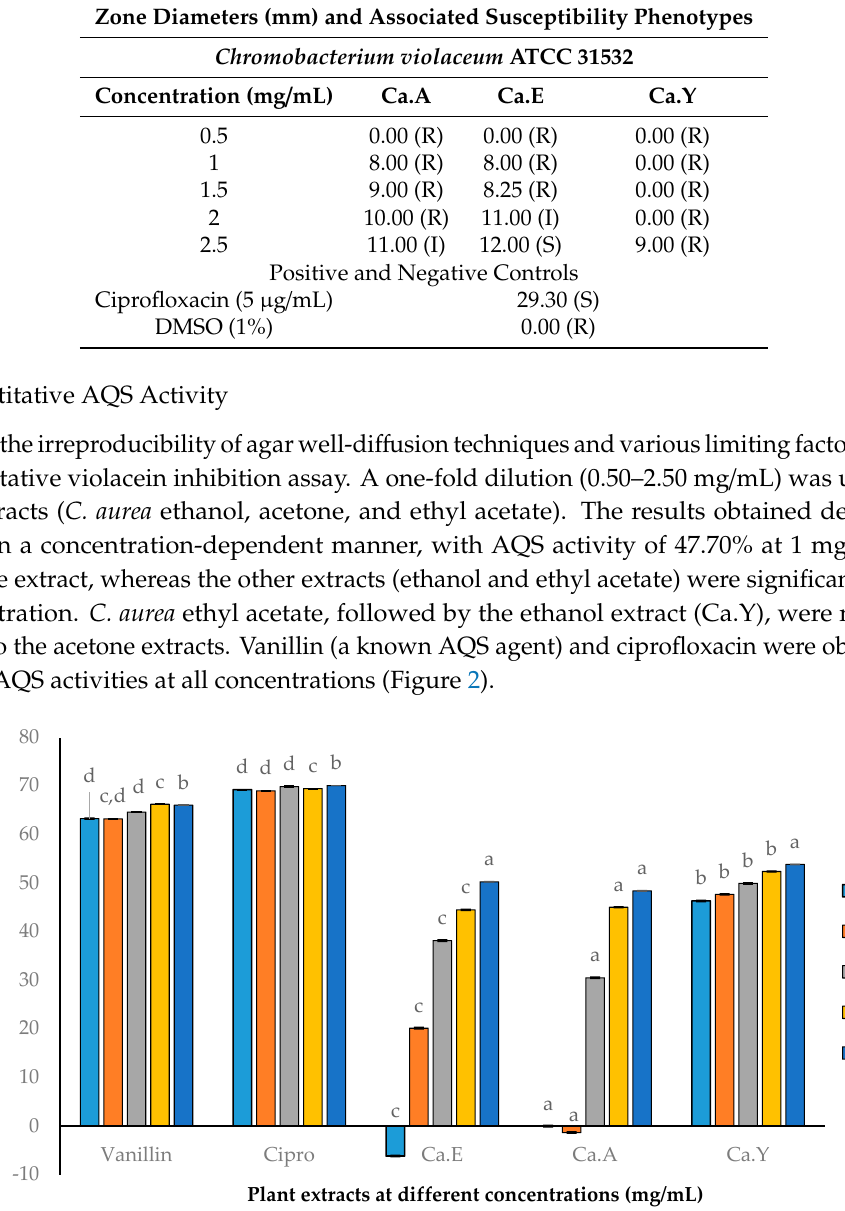
Table 2. Qualitative anti-quorum sensing (AQS) activity against a biomonitor strain of Chromobacterium violaceum C. aurea extracts, where Ca.A = Acetone, Ca.E = Ethanol, and Ca.Y = Ethyl acetate extracts, respectively. R = Resistant, I = Intermediate, and S = Susceptible.